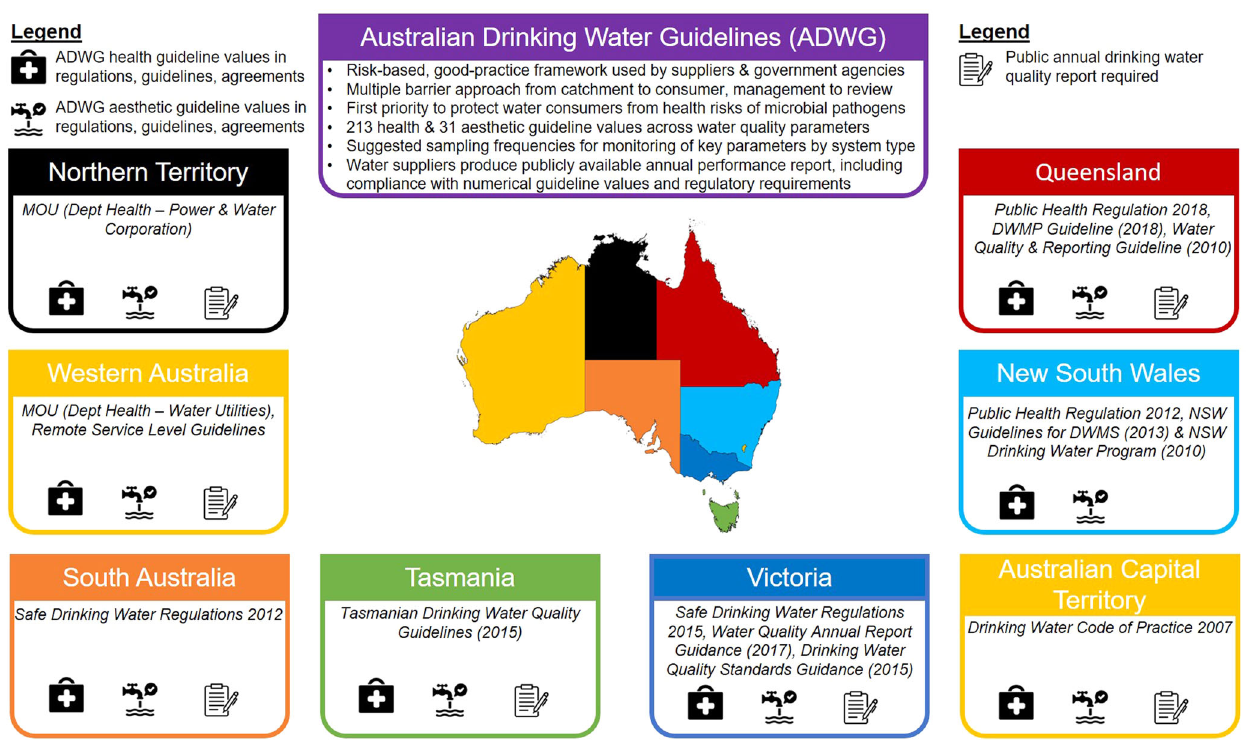
Fig. 1 Overview of monitoring and reporting under the Australian Drinking Water Guidelines and state/territory regulatory frameworks. Text in italics indicates regulatory documents referencing ADWG guideline values. Whether meeting health-based guideline values is mandatory varies across jurisdictions, parameters, and by the type of water supplier. Aesthetic guideline values are typically incorporated as non-mandatory objectives and/or reporting requirements only, except for turbidity in Victoria. Minimum standards for tested parameters and sampling frequencies may be speci fi ed across all suppliers in a jurisdiction or determined through tailored monitoring plans. New South Wales is the only jurisdiction where public annual reports are not a formal requirement; for other jurisdictions, non-public annual reporting to regulators only is typically required for water carters and very small suppliers. Icons downloaded from the Noun Project (https:// thenounproject.com/) using a NounPro for EDU Subscription.